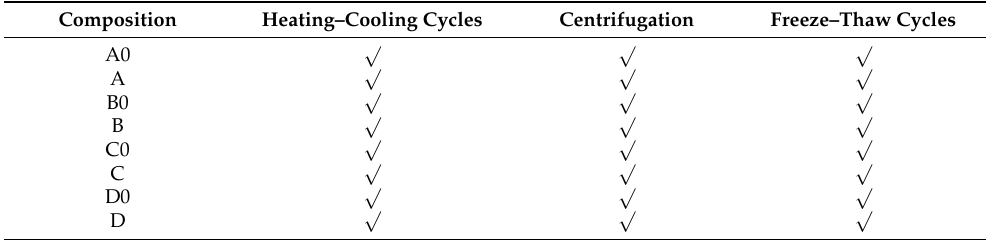
Table 2. Results of the thermodynamic stability tests. The samples were subjected to six heating– cooling cycles between 4 ◦ C and 45 ◦ C and three freeze–thaw cycles at alternating temperatures of − 21 ◦ C and 25 ◦ C. The formulations were centrifuged at 3500 rpm for 30